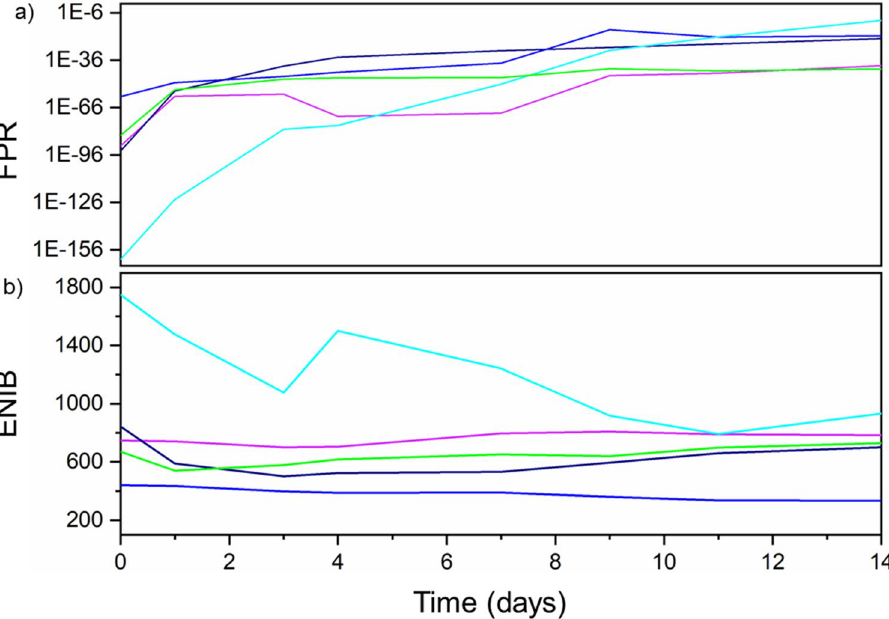
Figure 3. Top—A plot showing the false positive rate (FPR) of each Group 1 token type, which was derived by comparing fingerprints generated from photoluminescence images captured at the times shown after their creation. Bottom—Showing the effective number of independent bits (ENIB) extracted from each Group 1 token as a function of days since their